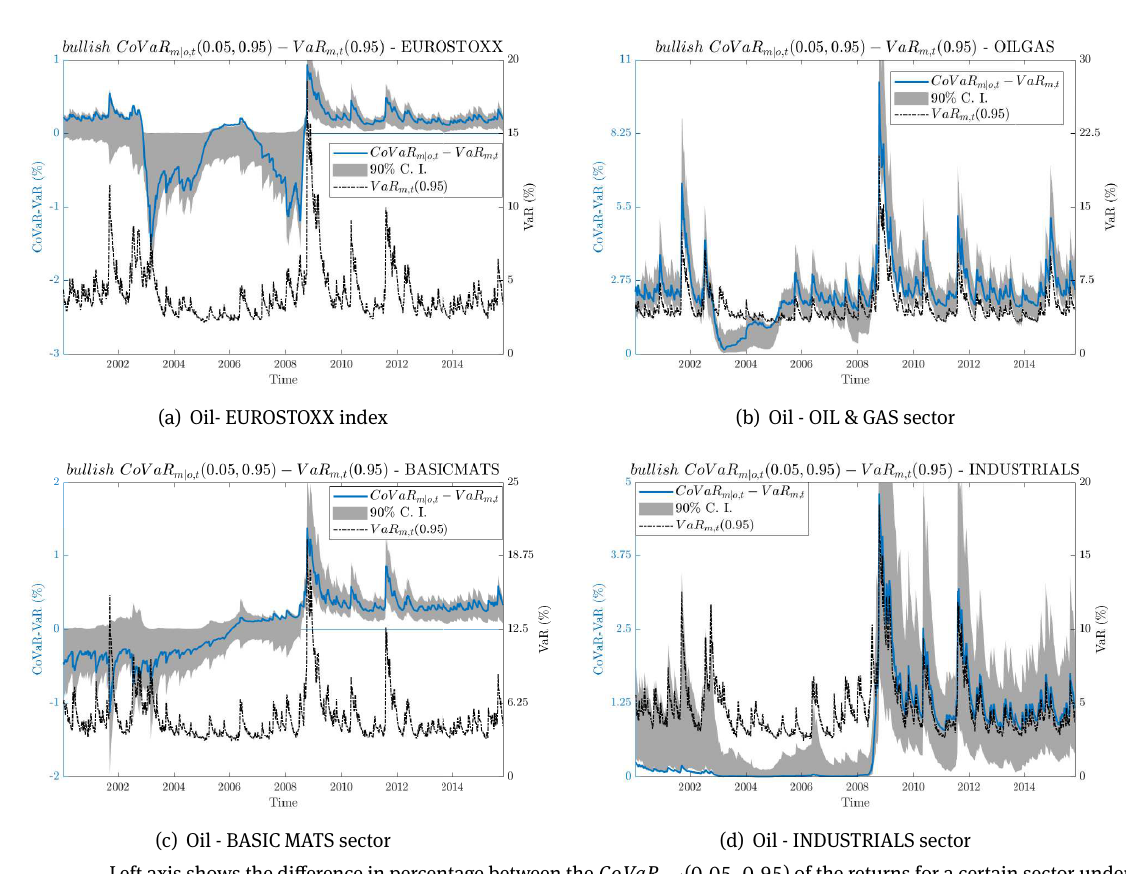
Figure 17a: CoVaR m | o , t (0.05, 0.95) for a certain sector given a bullish scenario for oil prices